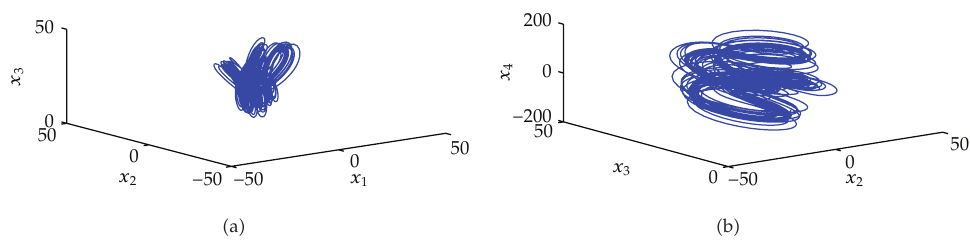
Figure 2: Hyperchaotic attractors of the fractional-order system (cid:2) 3.2 (cid:3) for q d (cid:8) 0 .